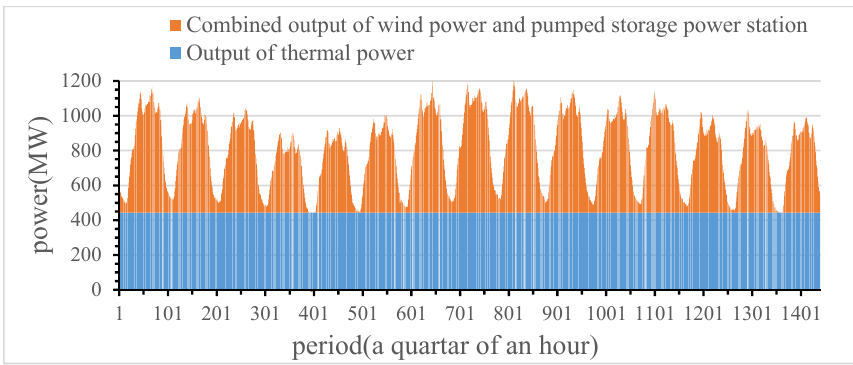
Figure 6. The load composition in heating off-peak period. 3 (cid:13) . The capacity of the pumped-storage power station